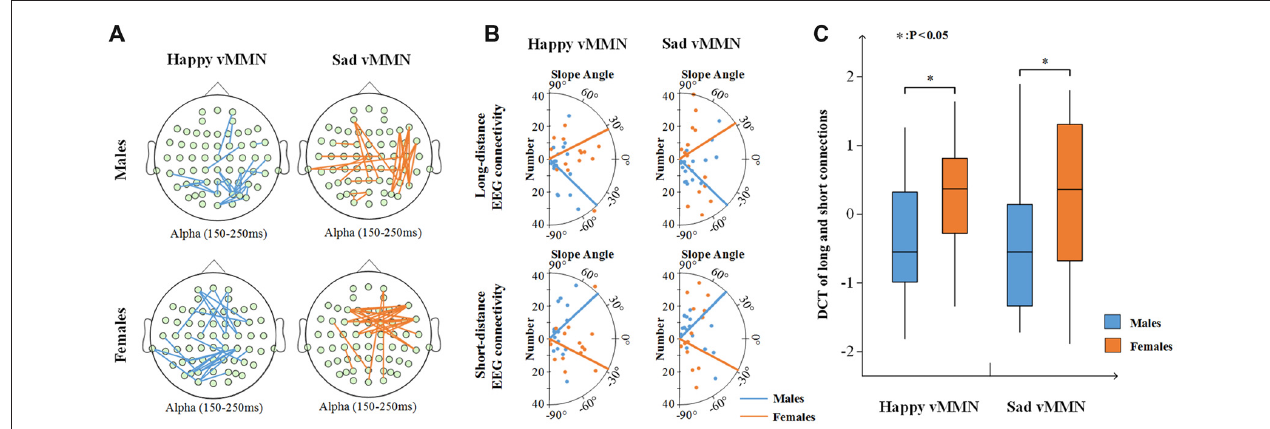
FIGURE 6 | (A) The top 25 connections of increased PLI values related to the deviant stimuli compared to the standard stimuli in terms of the alpha (150–250 ms) band activity. (B) The number of connections changed with the intensity of the top 30% of the PLI for long- and short-distance electroencephalography (EEG) connectivity. The dot represents the average number of long- or short-distance and the slope angle of the top 30% of the PLI for each participant. The line represents the average slope angle of the top 30% of the PLI for all participants. (C) Box figure of the average difference in the change trends (DCT) of the long and short connections for males and females. ∗ p <